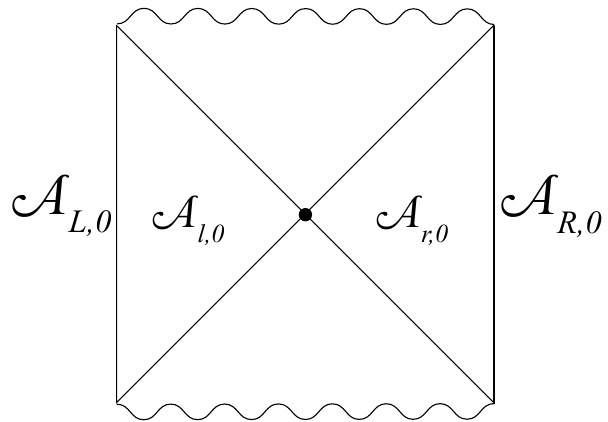
Figure 2 . The large N boundary algebras A R, 0 and A L, 0 are holographically dual to bulk quantum field theory algebras A r, 0 and A ‘, 0 associated to the right and left exterior